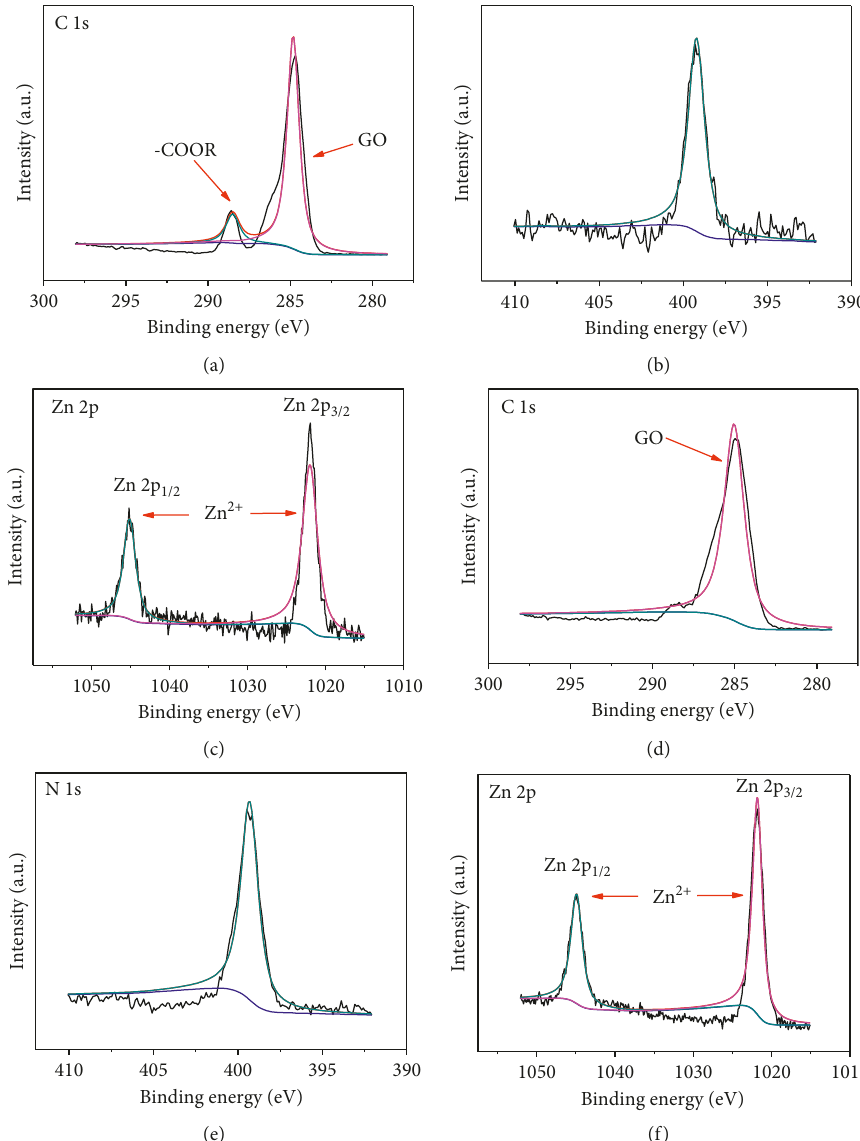
Figure 13: XPS spectra of different samples: (a)–(c) ZIF-8/GO powder; (d)–(f) TC-ZIF-8/GO